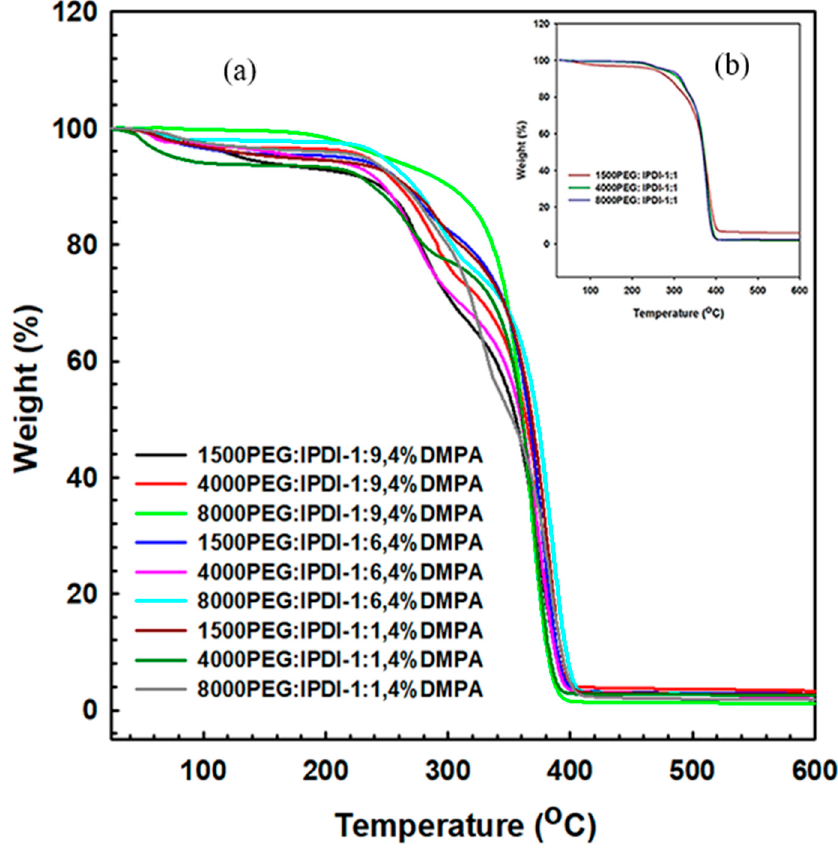
Figure 8. Thermal degradation properties of ( a ) WSPU ( b ) PUR without DMPA.